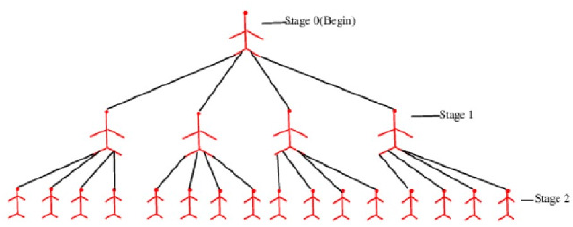
Figure 1. A pandemic tree with an eqidemiological R 0 value of 3. The reproduction number of a pandemic, rounded to the closest integer, is S 0 , and a pandemic tree is a full S 0